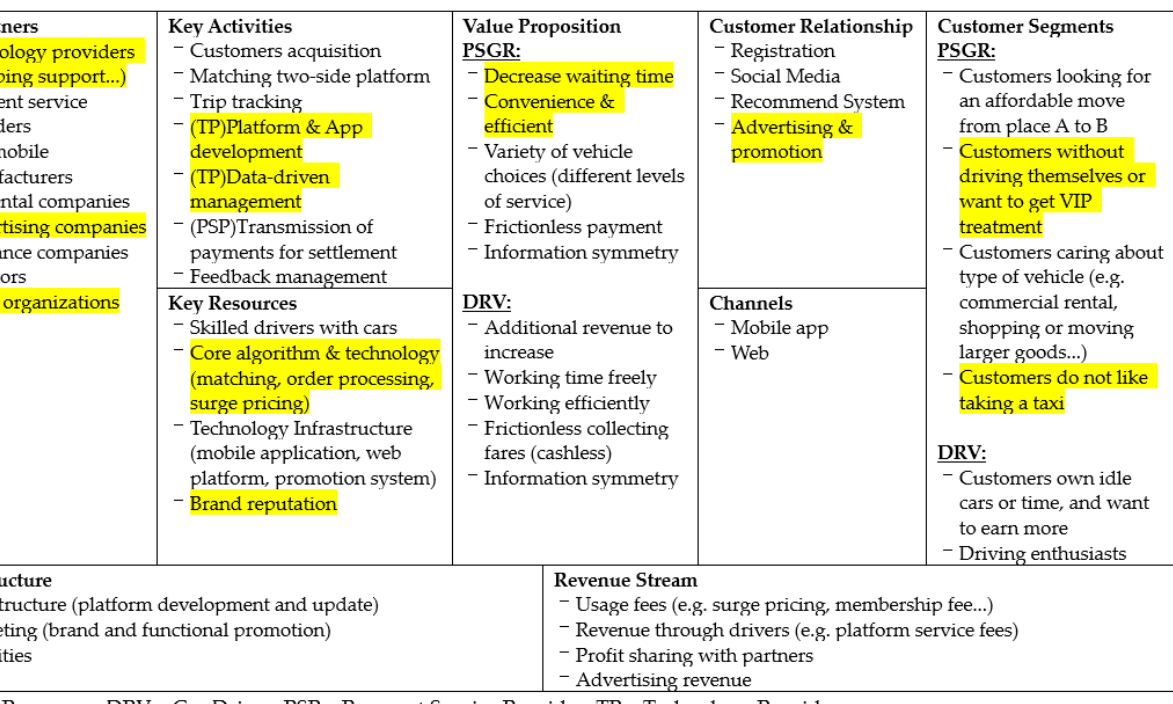
Figure 2. Canvas model of Uber China platform. There are not many studies that apply the canvas model to ride-hailing services such as Uber and DiDi. However, a few studies apply the canvas model to mobility as a service (MaaS). For example, [31] presents several types of sustainable open business models in the MaaS market using the canvas model. Among various kinds of MaaS alternatives, open innovation is shown to be the most difficult in the case of car-sharing operators, which are the closest to the subject of this study. As we will present below, we could draw some reasons for these findings by comparing and analyzing the canvas BMs of Uber and DiDi. For example, MaaS operators need to provide greater availability and flexibility for the potential users to increase the chance of success. Our study also confirms that DiDi was ahead in this dimension over Uber (refer to Sections 3.1.1 and